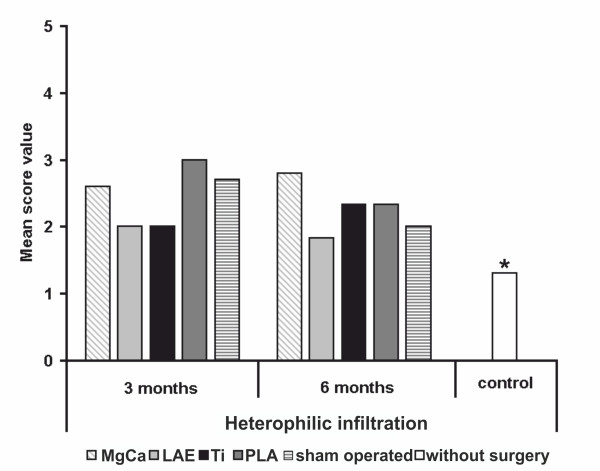
Score values of heterophilic infiltration for all examined groups. Note the absence of significant differences between all groups and evaluation times, except for the control group without surgery (* = p < 0.05). MgCa = MgCa0.8, LAE = LAE442, PLA = poly-96L/4D-lactide, Ti = TiAl6V4, sham operated = surgery without implant material, control = no surgery on the limb.